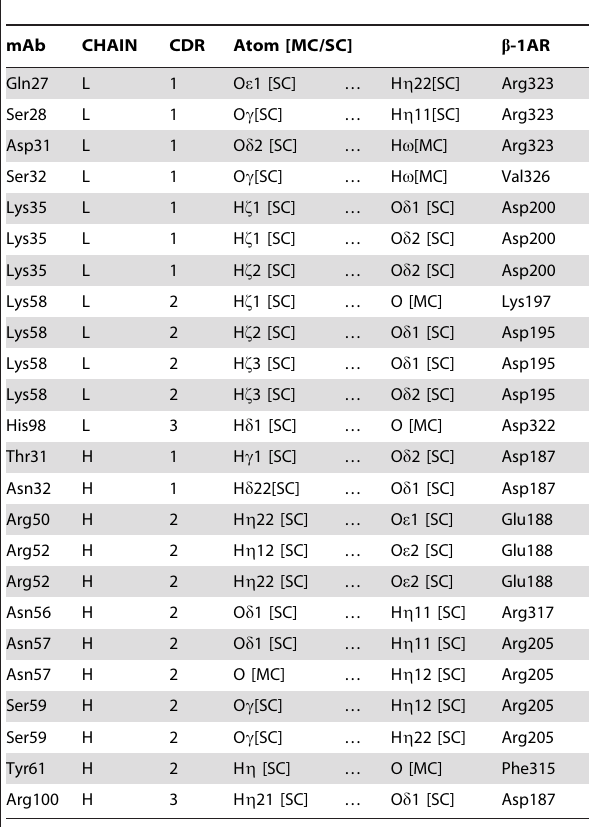
Table 3. Polar contacts in the model between 17.2 and b 1- AR.